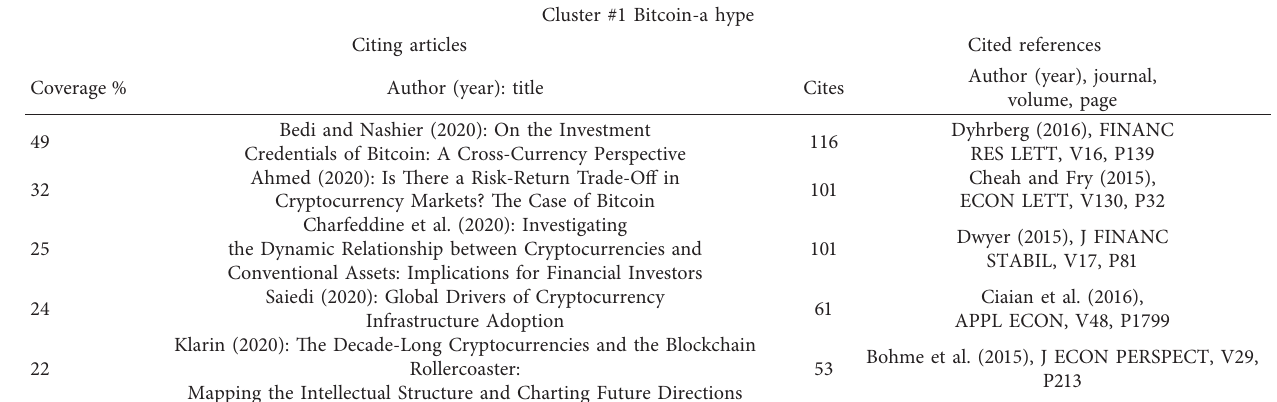
Table 4: Citing articles and cited references of Cluster